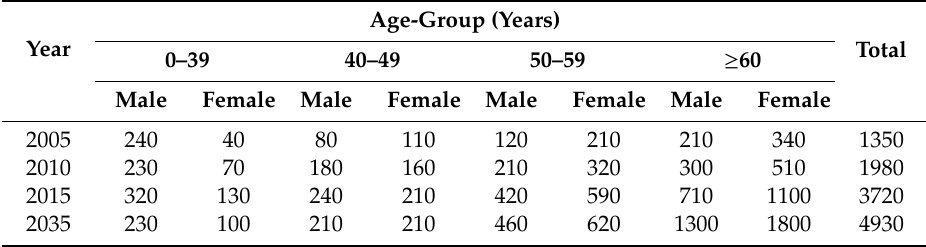
Table 1. Projection (in thousands) of the number of males and females with diabetes (prevalence) by age group for selected